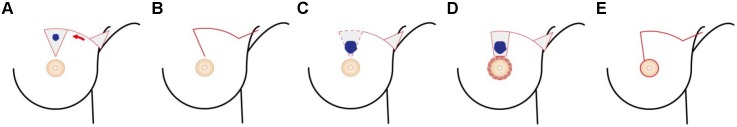
Surgical technique of the matrix rotation.The non-donut method was employed for those tumors which could be resected by a reverse-triangular shaped en bloc resection with negative margins (A). A concave incision was made along the lateral border of the breast from the tumor site to the midaxillary line, followed by a small triangular-shaped incision in the axilla to facilitate lymph node management and subsequently flap advancement (B). For tumors located less than 3 cm away from NAC or if safety margins could not be obtained by non-donut en bloc resection (C), the donut method was used which involved periareolar de-epithelialization and en bloc resection in a rectangular shape (D and E).